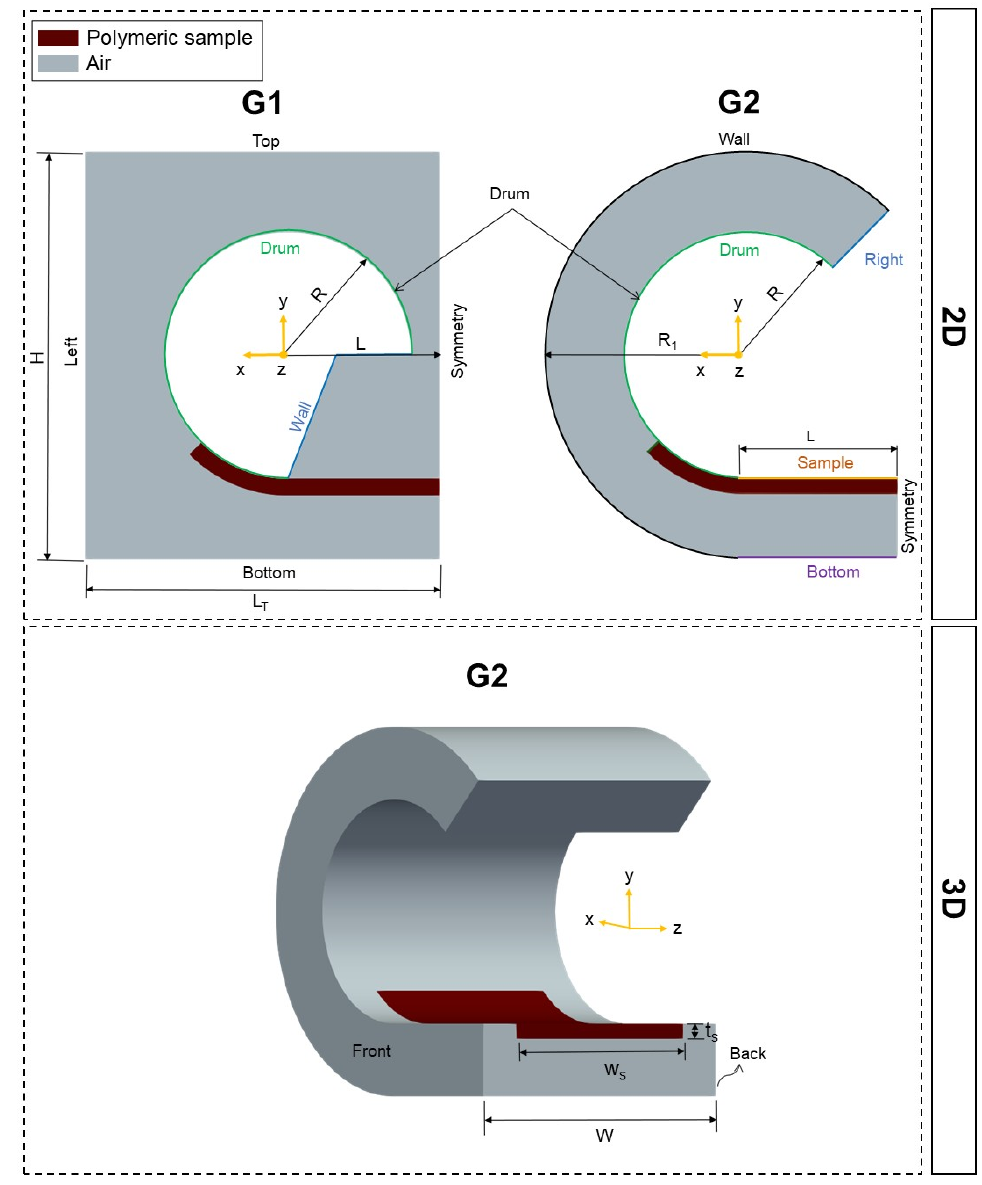
Figure 2. Geometries employed on the computational